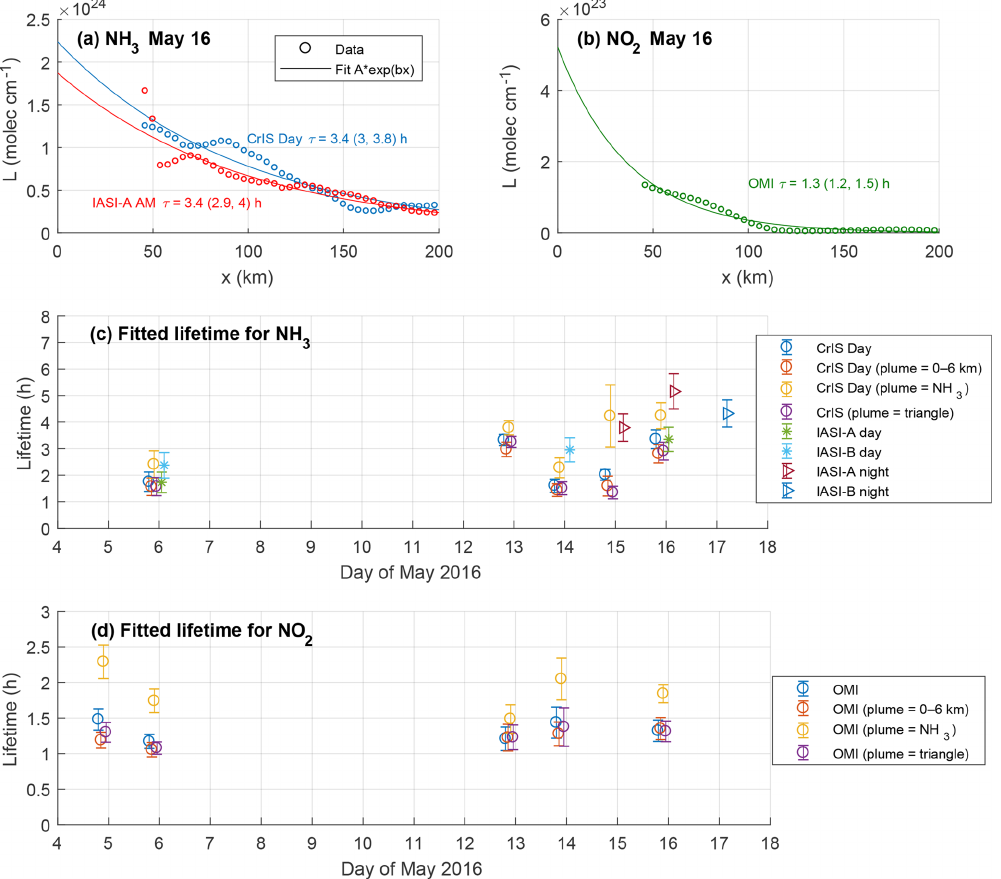
Figure 5. Fitted lifetimes for NH 3 and NO 2 . Example of fits on 16 May for (a) NH 3 from IASI morning and CrIS daytime and (b) NO 2 from OMI, with lifetime fit and 95% confidence intervals given in the text box. Lifetimes and 95% confidence intervals from fits for (c) NH 3 and (d) NO 2 . Note that in panels (c) and (d) markers are offset from each other on the x axis to improve the readability of the